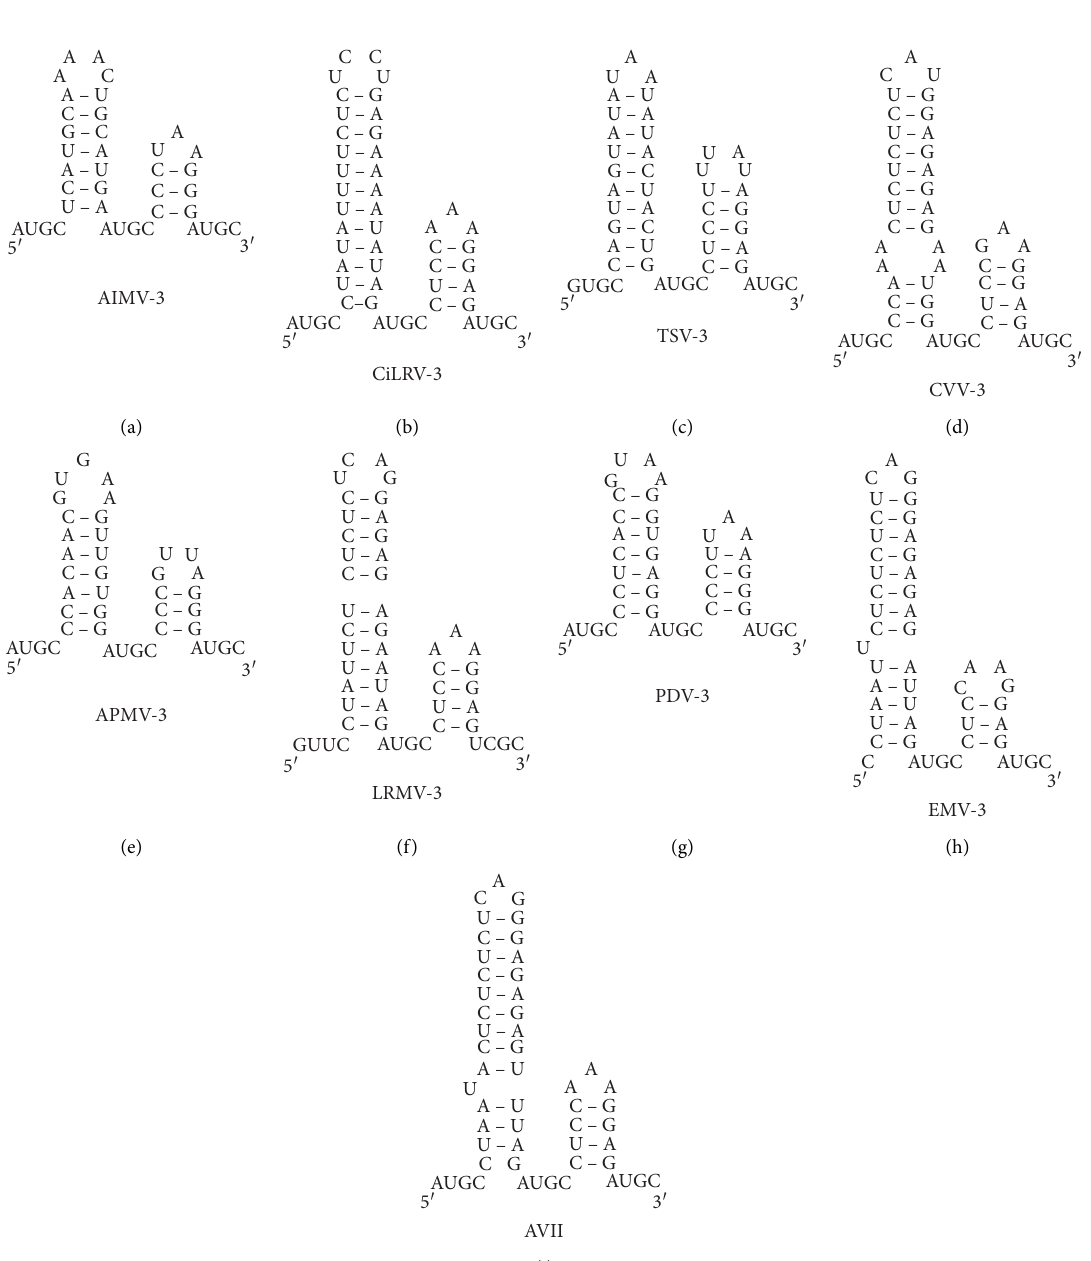
Figure 5: Secondary structure information of nine